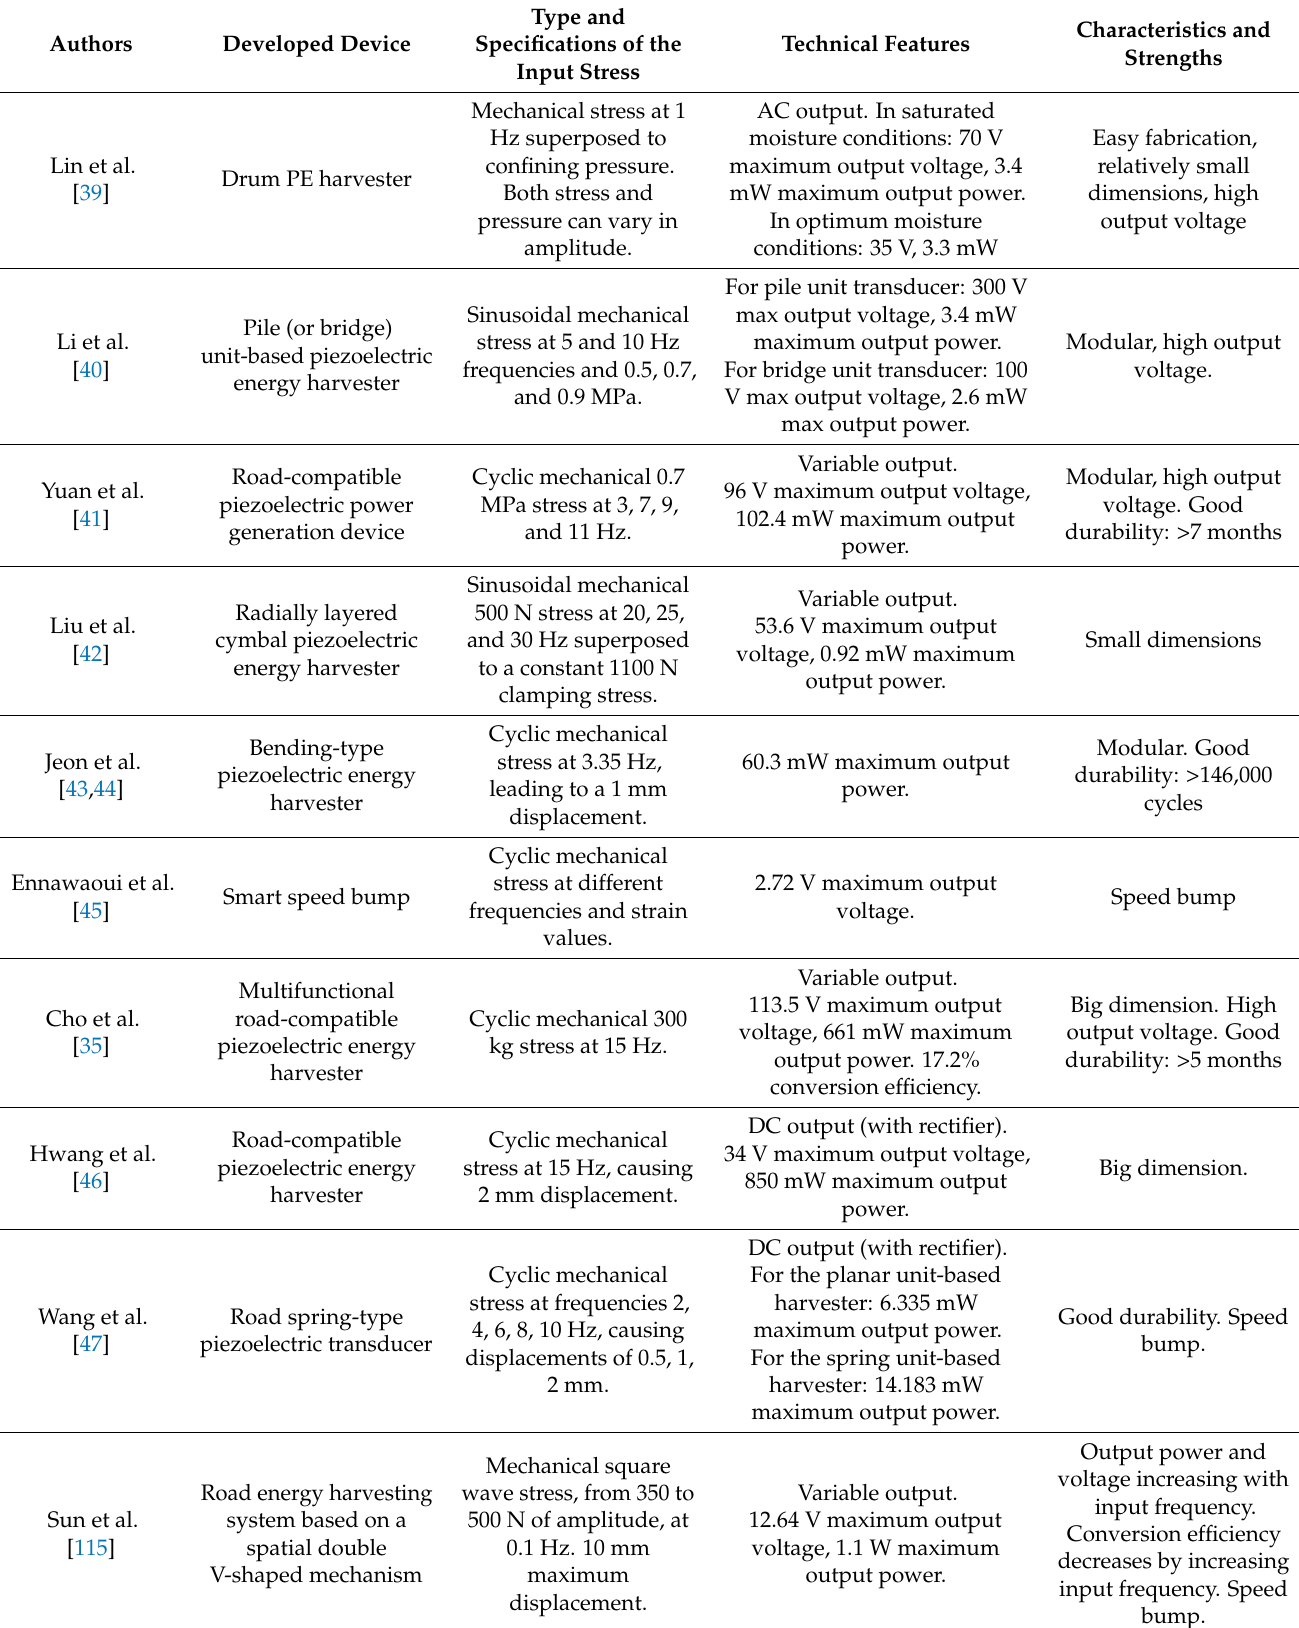
Table 3. Comparison of different energy harvesting solutions along roads found in the